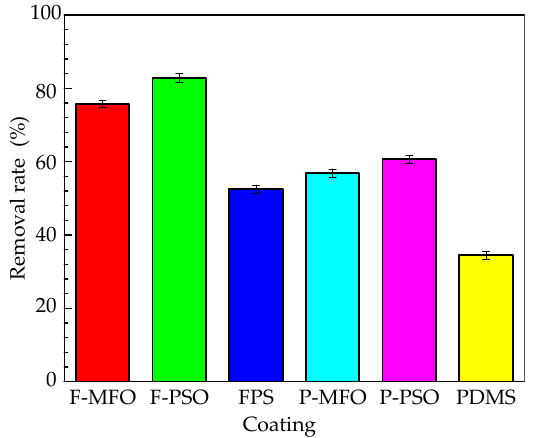
Figure 12. Chlorophyll a concentration of Navicula Tenera on studied coatings.